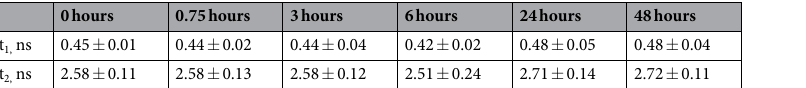
Table 1. Fluorescence lifetimes of NAD(P)H in HeLa cells before (0 hours) and during the course of 48-hours of treatment with cisplatin. Mean ± SD, n =